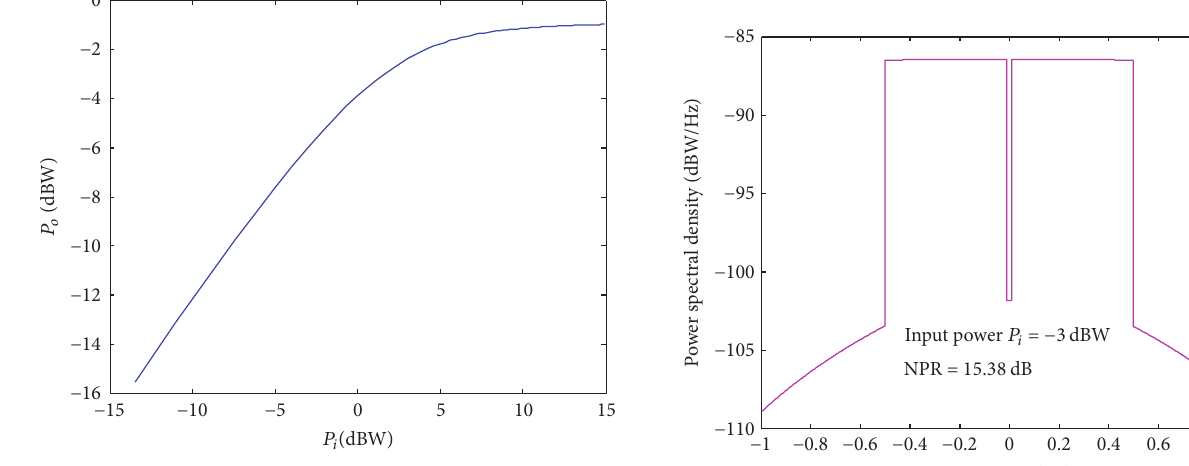
Figure 6: Amplifier output versus input power level. approximation of 𝐹(𝑢) over the interval ( − 3, 3) and are equal to [0.7962 −0.1284 0.0165 −0.0013 4.12 × 10 −5 ] . The